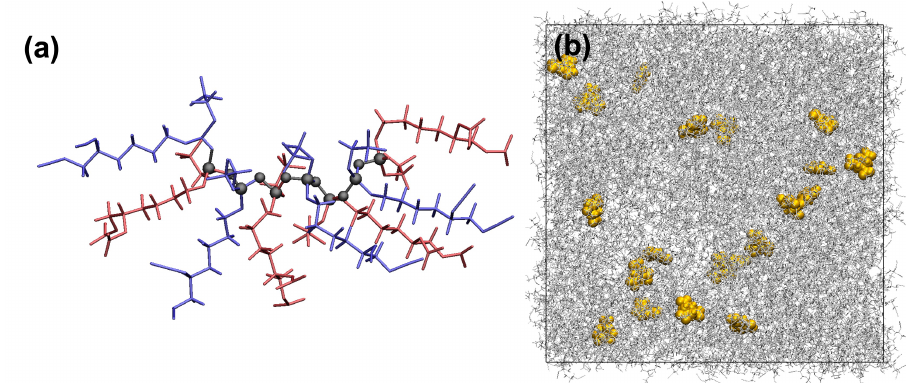
Figure 6. ( a A representative polymer chain comprised of alternated monomers of PZ-Azido (in blue) and PZ-Nitrato (in red). The black spheres represent the reacted head and tail atoms. ( b ) A representative simulation cell where RDX molecules (in yellow) were randomly distributed in the p-PZ-Azido system (in grey).